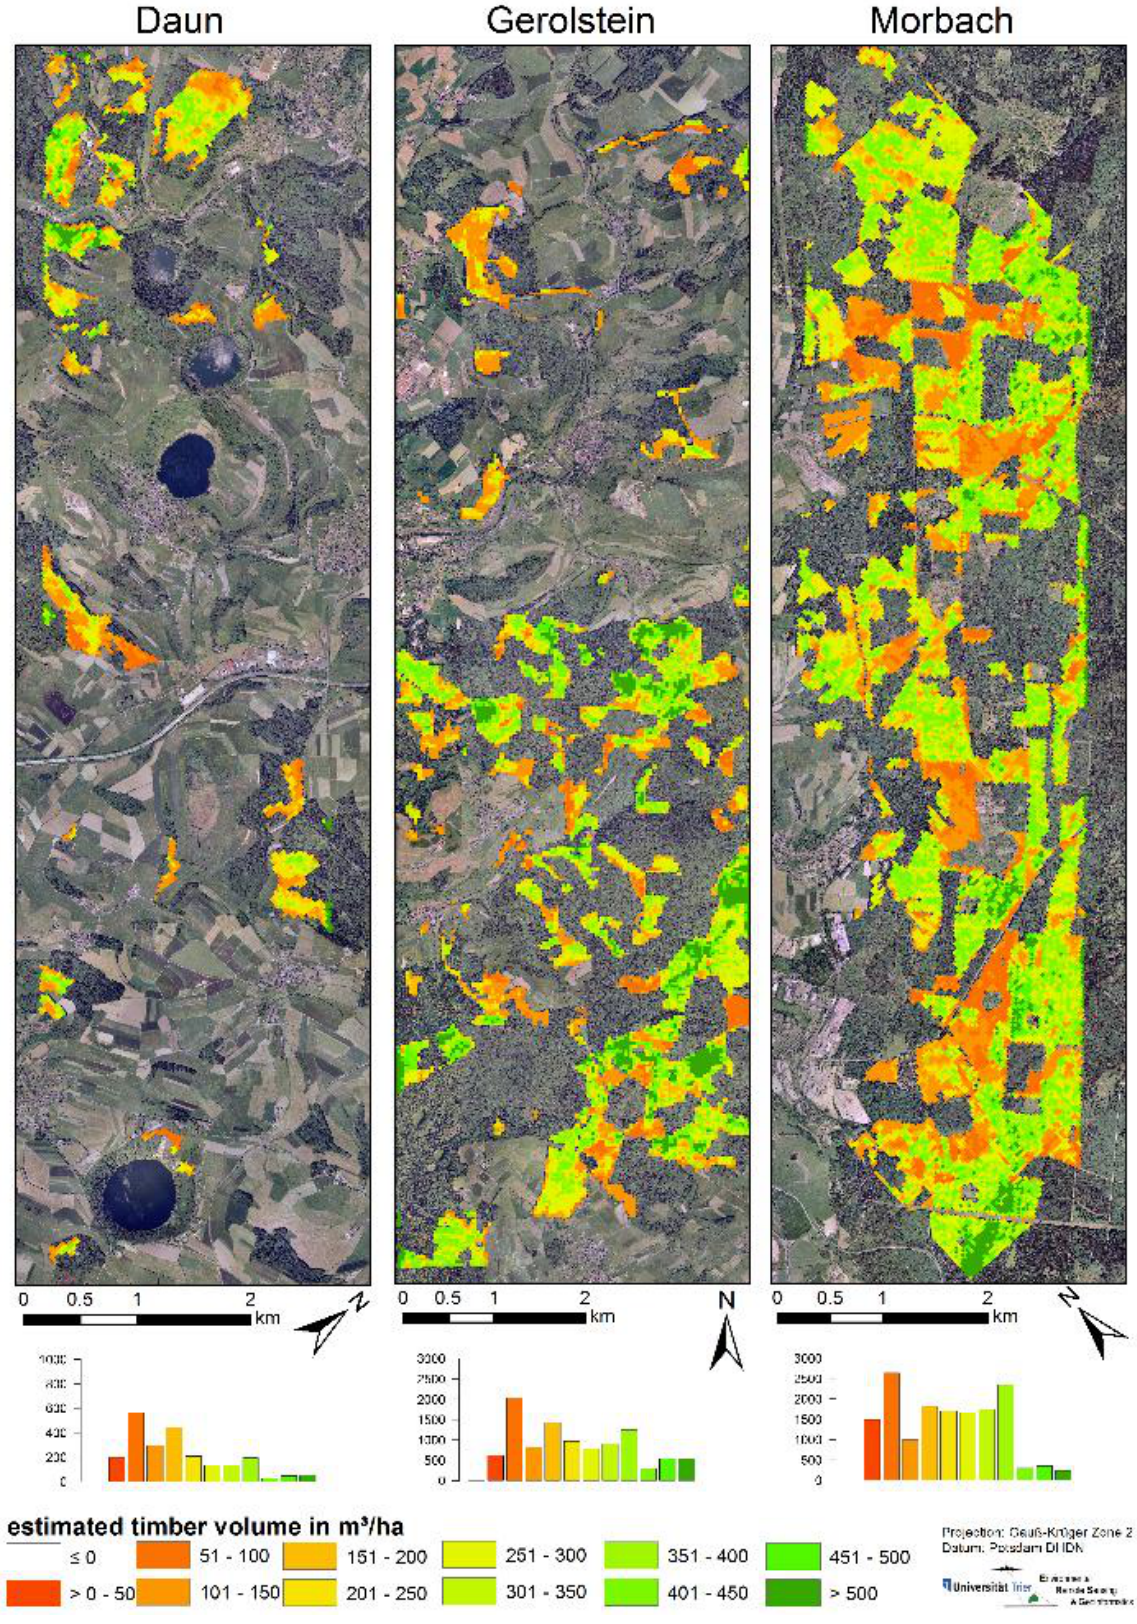
Figure A2. Timber volume prediction map based on k -NN with simulated EnMAP